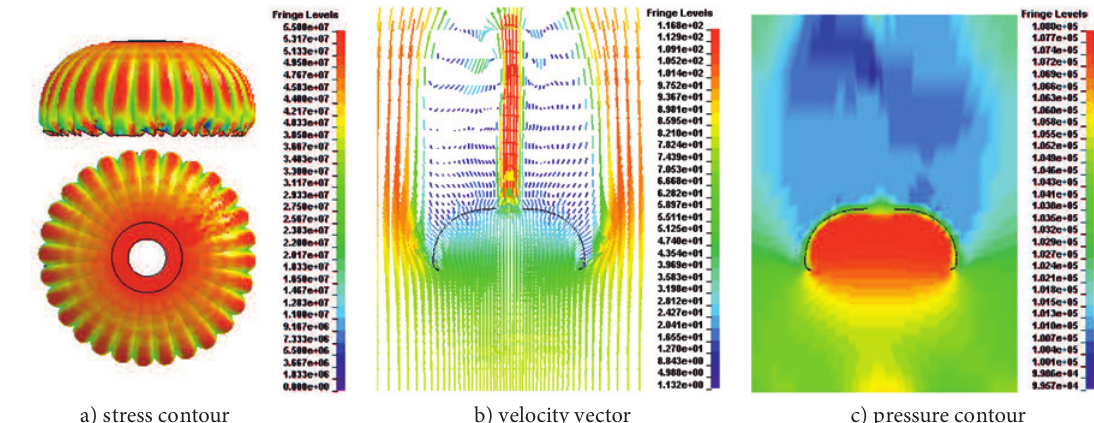
Fig. 8. Structural an d flow fie ld results a t t = 0.897 s